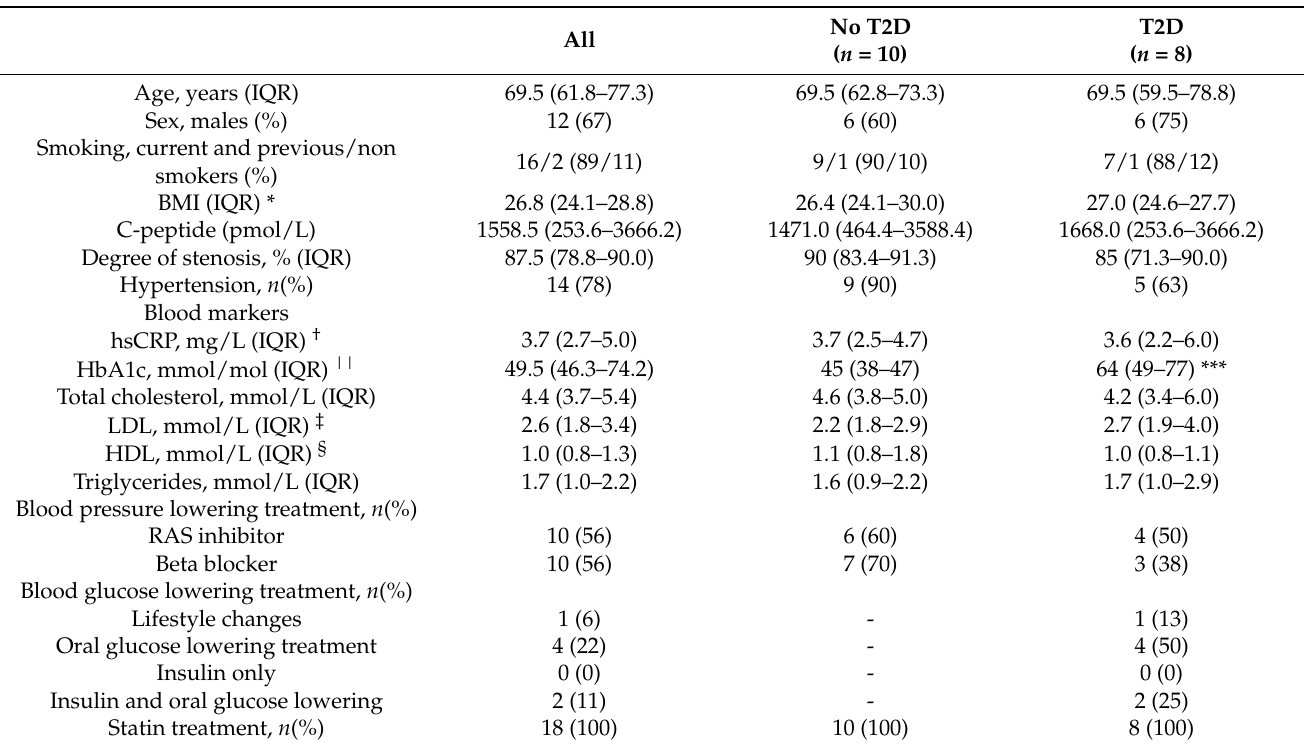
Table 1. Categorical variables are expressed in total amount and percentages. Continuous variables as median and interquartile range (IQR) or mean and standard deviation (SD). * BMI, body mass index. † hsCRP, high-sensitivity CRP. ‡ LDL, low-density lipoprotein. § HDL, high-density lipoprotein. || HbA1c, hemoglobin A1c, was available for 67% ( n = 12) of the cohort. Hypertension defined as: anti-hypertensive treatment or systolic pressure > 140 mmHg. Level of significance between no diabetes and T2D patients is marked by *** p <